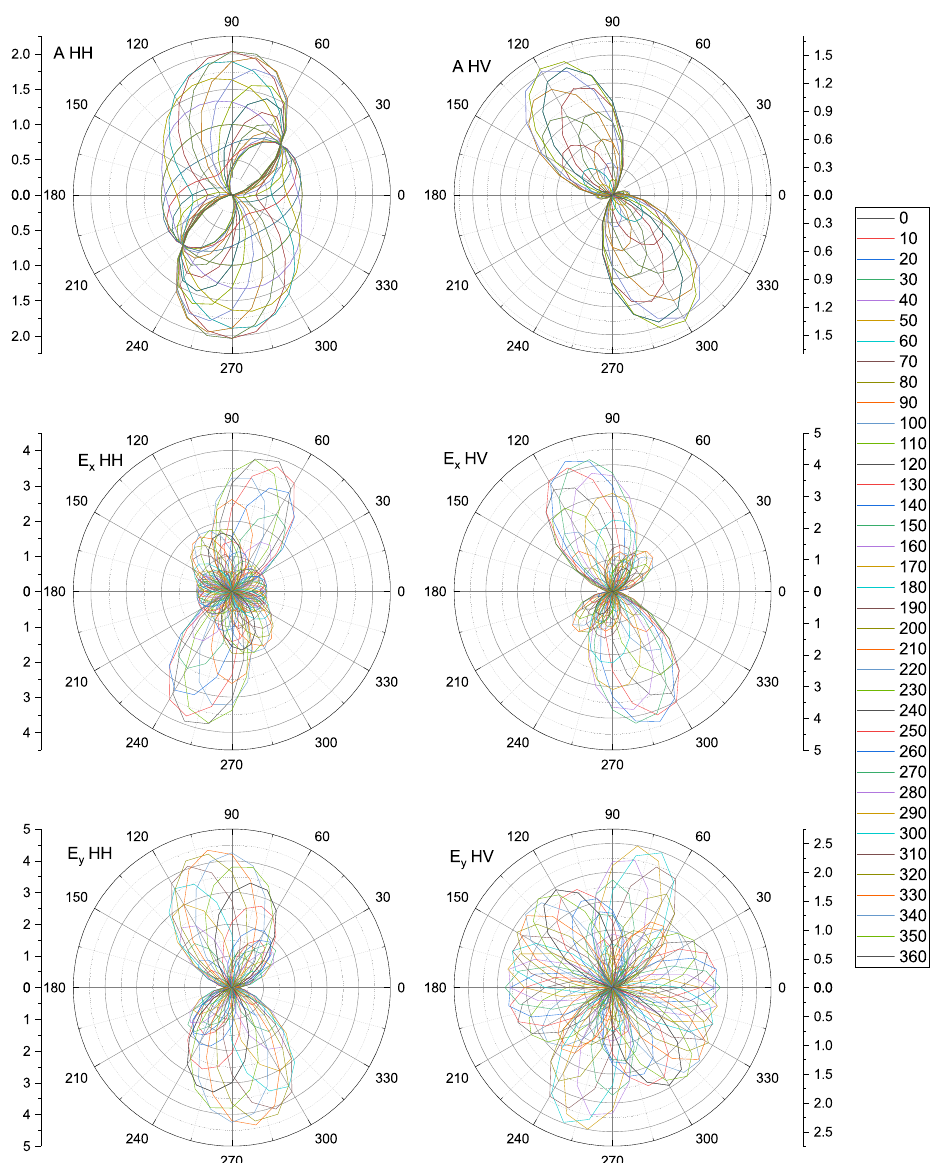
Figure A1. Calculated intensity dependence of Raman modes in the HH and HV polarisation on rotation angle in plane. The angle to z -axis is 30